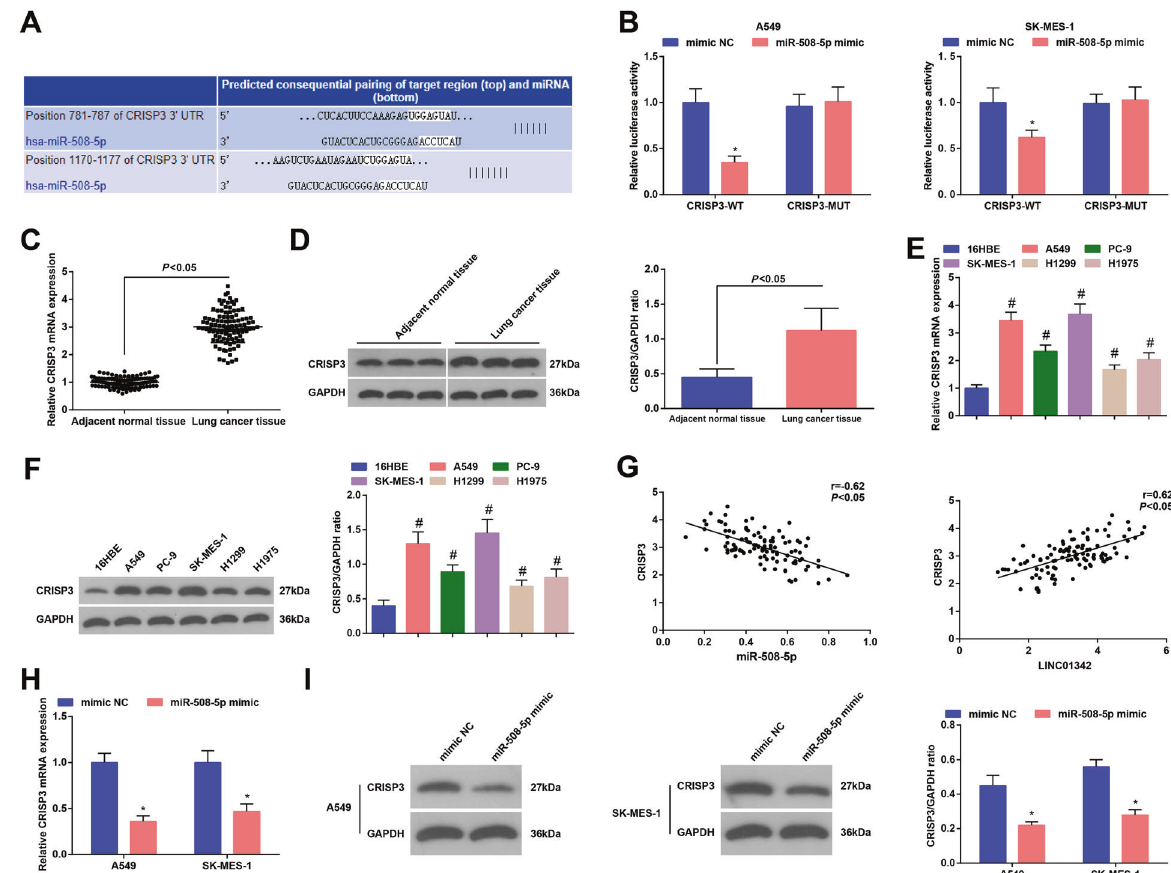
Fig. 5 MiR-508-5p directly targets CRISP3. A Binding site between miR-508-5p and CRISP3 was predicted at Targetscan. B Targeting relationship between miR-508-5p and CRISP3 was con fi rmed using dual luciferase reporter gene assay. C mRNA expression of CRISP3 in LC tissues was determined using RT-qPCR. D Protein expression of CRISP3 in LC tissues was determined using Western blot analysis. E mRNA expression of CRISP3 in LC cells was determined using RT-qPCR. F Protein expression of CRISP3 in LC cells was determined using Western blot analysis. G Correlations between miR-508-5p and CRISP3, and between LINC01342 and CRISP3 were analyzed using Pearson test. H CRISP3 mRNA expression after miR-508-5p upregulation was detected using RT-qPCR. I CRISP3 protein expression after miR-508-5p upregulation was detected using Western blot analysis; * P < 0.05 vs. the mimic NC group; # P < 0.05 vs. 16HBE